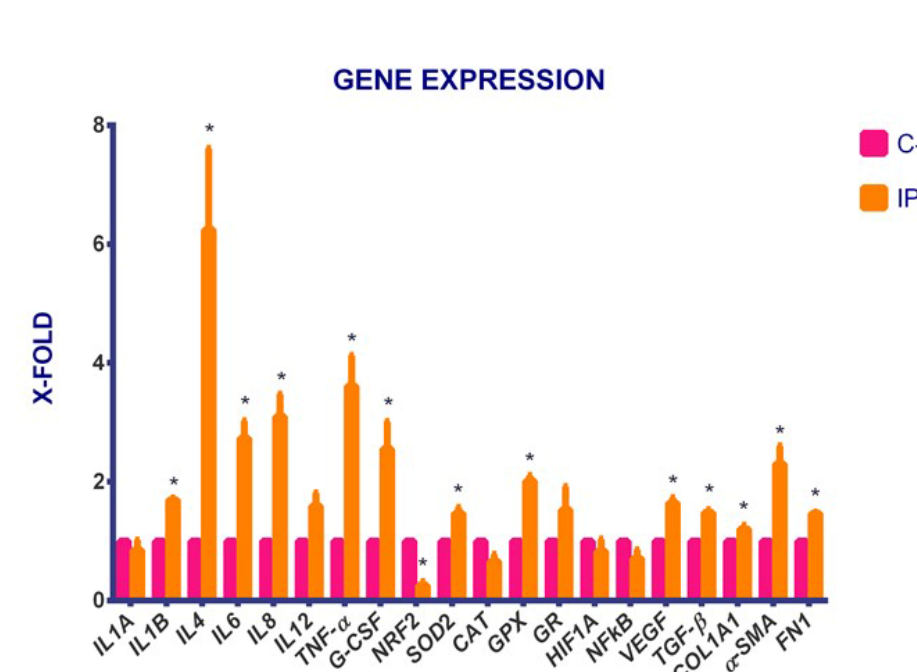
Figure 5. C-MSCs vs. IPF-MSCs: gene expression. The histogram displays the expression of selected genes referred specifically to inflammation ( IL1A , IL1B , IL4 , IL6 , IL8 , IL12 , TNF-α, and G-CSF ) and to other related pathways such as hypoxia ( HIF1A , NFkB, and VEGF ), oxidative stress ( SOD2 , CAT , GPX , GR, and NRF2 ) and ECM pathway ( TGF-β1 , COL1A1 , α-SMA, and FN1 ) in C-MSCs and IPF-MSCs. Levels of expression detected in IPF-MSC are referred to as X-fold with respect to C-MSC (express as 1). Data are mean ± SD, over three independent experiments. The * indicates significative differences referred to C-MSC (one-way ANOVA; p < 0.05). C-MSCs: mesenchymal stem cells (MSCs) from